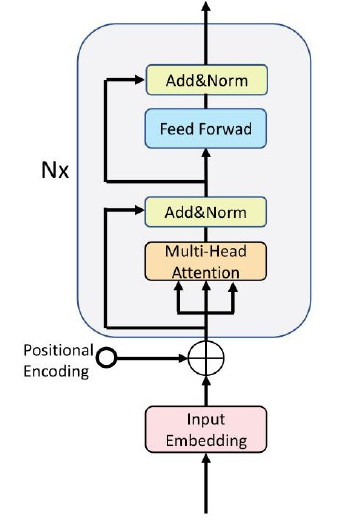
Figure 2. BERT model